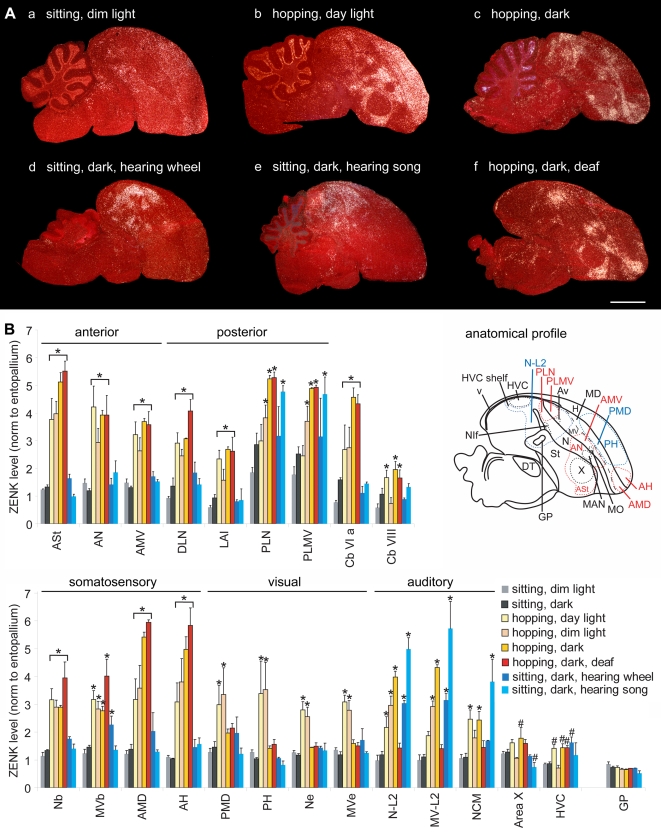
Movement-induced ZENK expression in zebra finches.A. Sagittal sections of birds (a) sitting relatively still in dim light, (b) hopping around the perimeter of a cylindrical cage in day light, (c) hopping in a rotating wheel in the dark, (d) sitting still in the dark and hearing a bird hop in the rotating wheel, (e) sitting still in the dark and hearing playbacks of zebra finch song, and (f) hopping in the rotating wheel in the dark while deaf. The anatomical profile in the lower right highlights the extent of the movement-induced (red) and visual- and auditory-induced (blue) gene expression. Anterior is right, dorsal is up. Scale bar, 2 mm. B. Quantification of ZENK expression levels in 23 brain regions in 8 groups of male zebra finches. Except for a small difference in cerebellum lobule VI, there were no significant differences between sitting still dim light and dark animals; thus, they were treated as one control group for statistical analysis. * = p<0.05 to<0.0001, one-way ANOVA followed by Holm-Sidak multi-comparison test relative to combined values of sitting still animals in dim light+dark (n = 3–6/group). Lines underneath *s indicate brain areas with statistically significant increases exclusive to the moving groups. #s alone indicate values that approached significance by a few tenths of decimal in the ANOVA test. Error bars, S.E.M.